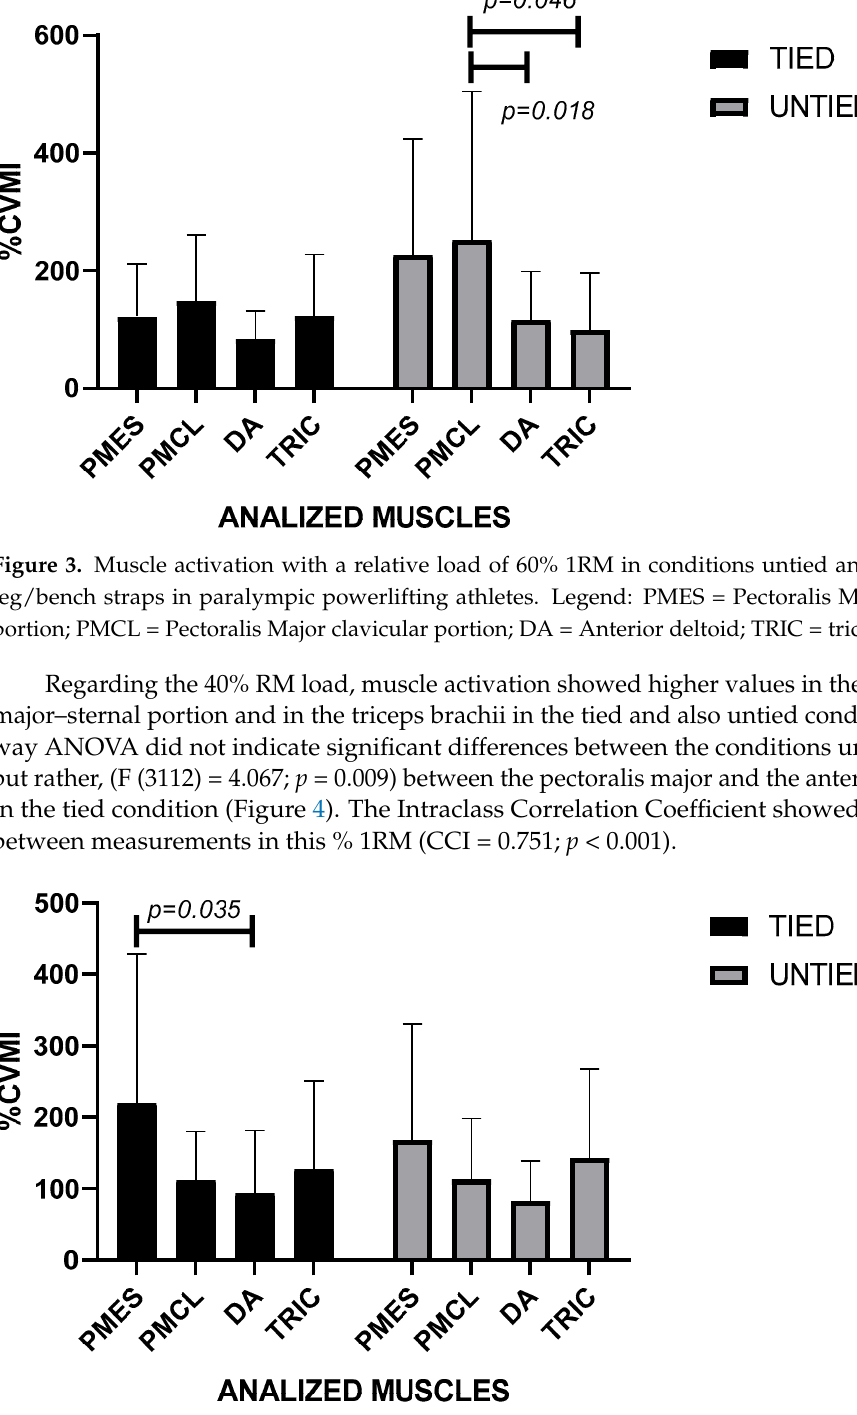
Figure 4. Muscle activation with a relative load of 40% 1RM in conditions untied and tied with leg/bench straps in paralympic powerlifting athletes. Legend: PMES = Pectoralis Major sternal portion; PMCL = Pectoralis Major clavicular portion; DA = Anterior deltoid; TRIC = triceps brachii.